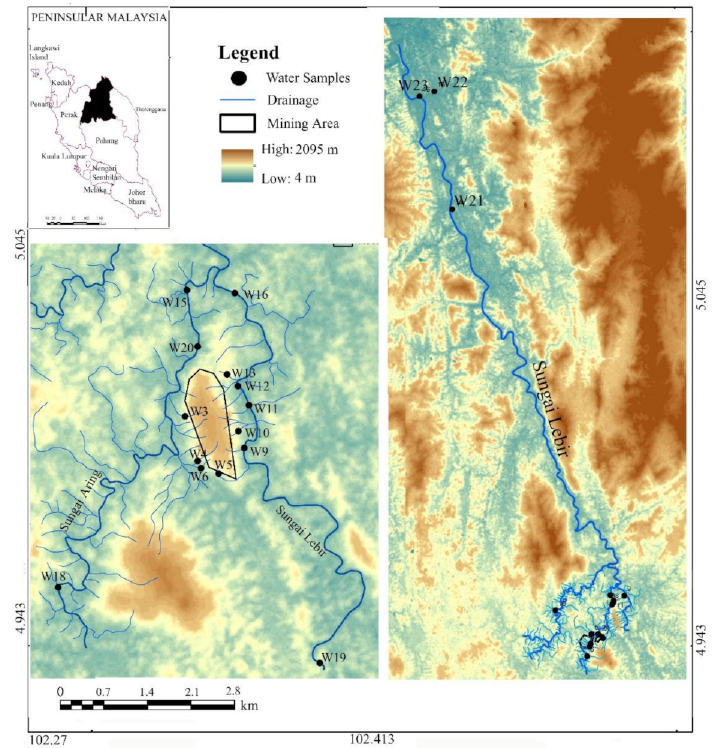
Figure 1. Location of water sampled and study